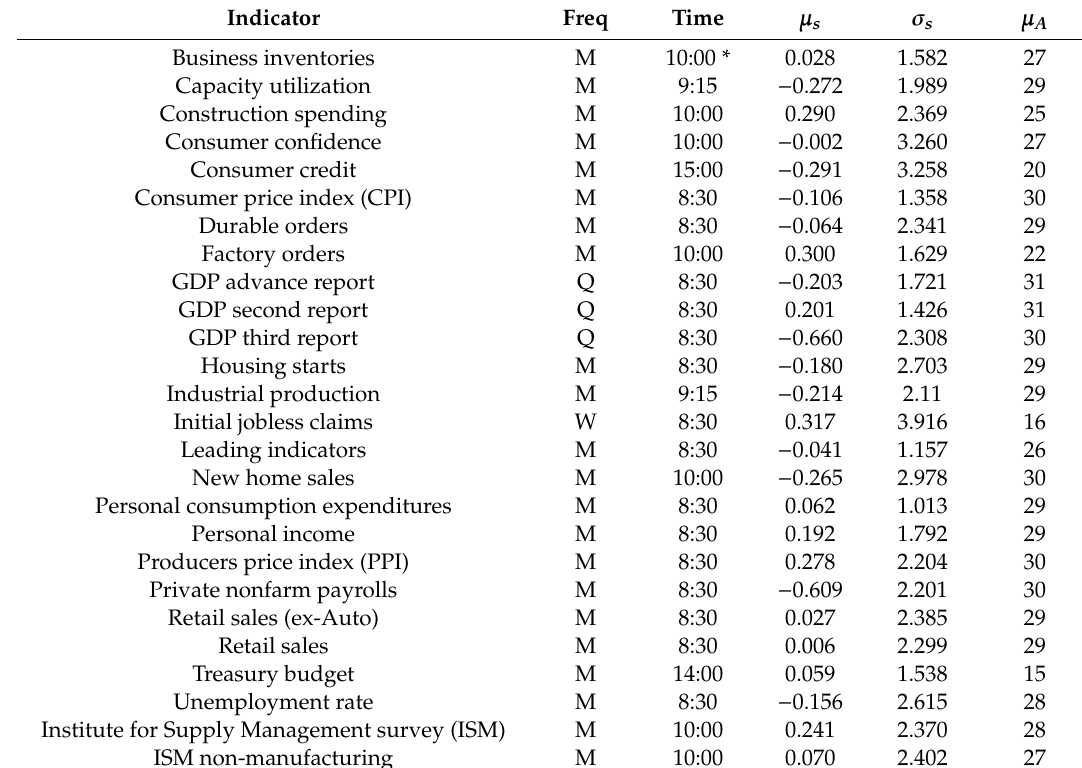
Table 1. List of macroeconomic announcements.